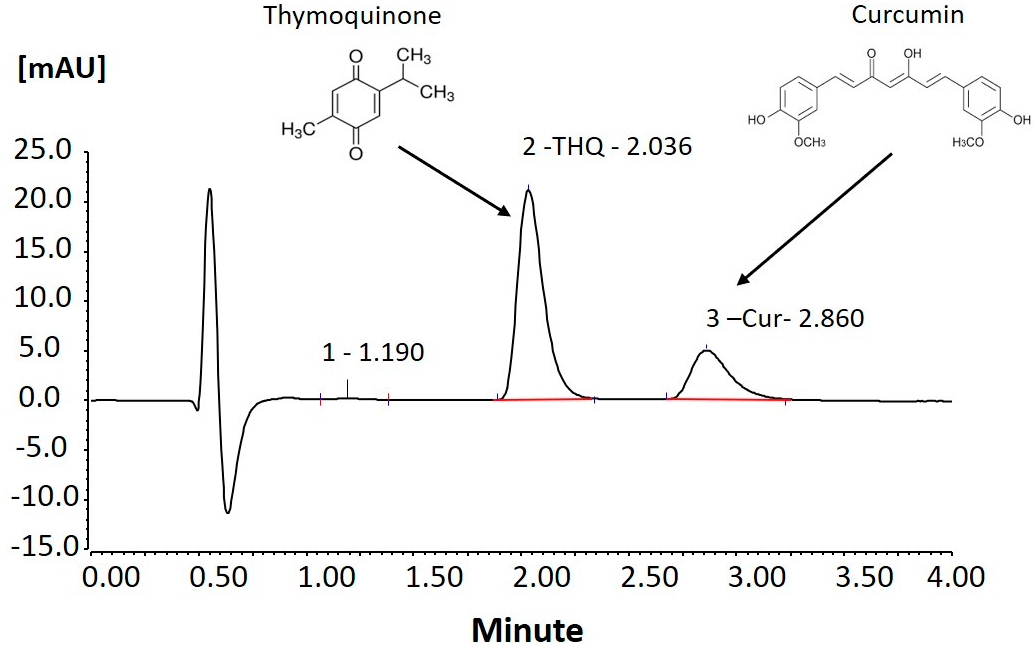
Figure 1. Chemical structure and UHPLC detection peaks of thymoquinone (MW-164.20, MP-41-51 °C) and curcumin (MW-368.38, MP-183 °C).